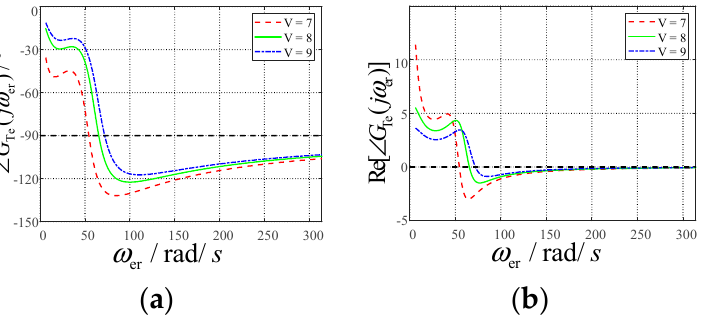
Figure 7. Frequency response of the gain of ∆ T e under different wind speeds: ( a ) phase vary with ω er ; ( b ) real part vary with ω er .